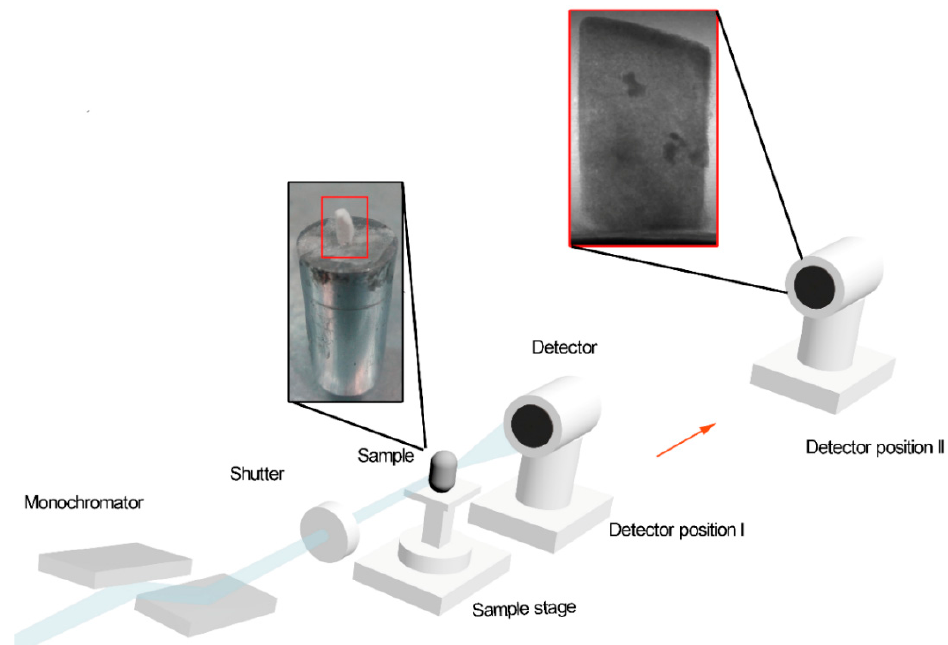
Figure 1. Schematic layout of in-line phase-contrast X-ray tomography.